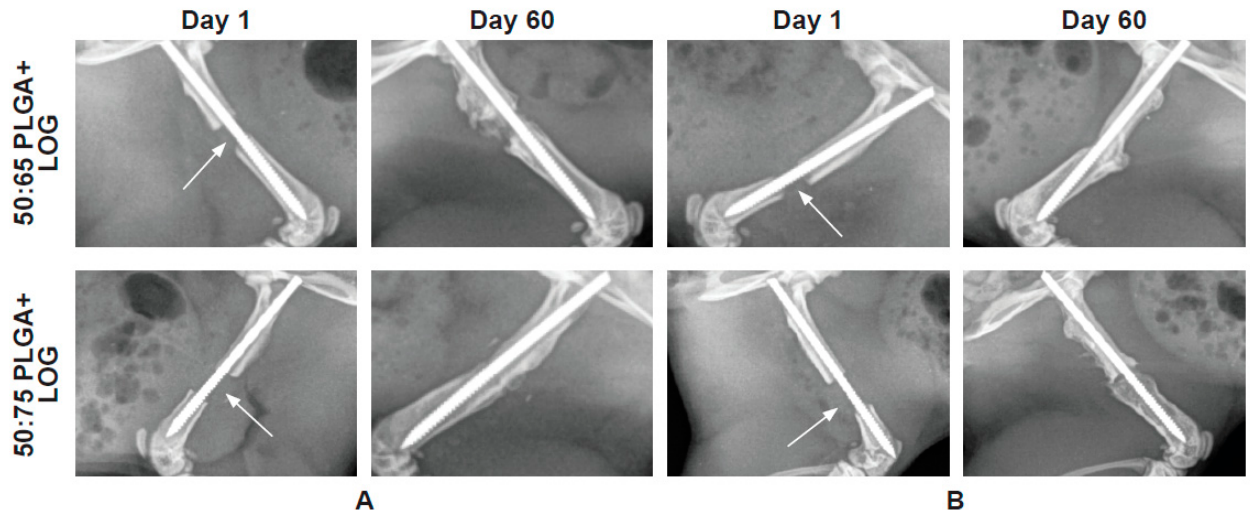
Figure 4. Radiography. Representative images of the rat femoral defects treated with the two scaffolds of poly(lactic-co-glycolic acid and low oxygen graphene (PLGA + LOG) alone (( A )—acellular) and with 1 × 106 hAD-MSCs (( B )—cellular) at days 1 and 60.The arrows show the defect at day 1, which is filled by day 60. The scaffolds are radiopaque and hence are not visible in the radiographs. At sacrifice, each implant was harvested and analyzed by microCT to evaluate the percentage bone volume as an endpoint measure of bone healing within the defects. A range of threshold levels was established to evaluate the bone masses at multiple density levels to reduce the difference between cortical bone and trabecular bone and capture the new and mineralized tissues. The analyzed ROI included the defect region and the adjacent, newly formed bone. Each ROI was analyzed at four different thresholds, ranging from 45–255 Hounsfield units. The scans were segmented at each threshold range to capture all new bone and calculate the percentage ratio of bone volume to total volume (%BV/TV) of the implant; this was analyzed with respect to the intact phantom femur. Even though there were no differences in any of the groups when the total range of 45–255 was compared, there were statistically significant differences in specific threshold ranges, indicating differences in the level of mineralized tissues present in each group. For instance, there was a consistently significant increase in response in the animal groups treated with the acellular and cellular 50:75 PLGA + LOG scaffolds in the range of 105–255 units, suggesting a corresponding increase in mineralized tissue (Figure 5). The results showed that the percentage of mineralized tissue in the group treated with 50:75 + hADMSCs was 51.16%, which was the highest and closely matched the value obtained for the phantom (49.97%), providing evidence that this may correspond to the trabecular bone in the ROI. Thus, the data demonstrate the osteoconductive potential of the 0.05 wt% LOG and the stable osseointegration of the 50:75 PLGA + graphene construct with the host tissue. This observation was ultimately confirmed by a positive Von Kossa staining of the mineralized bone tissues in the undecalcified samples. (Figures 5 and 6).